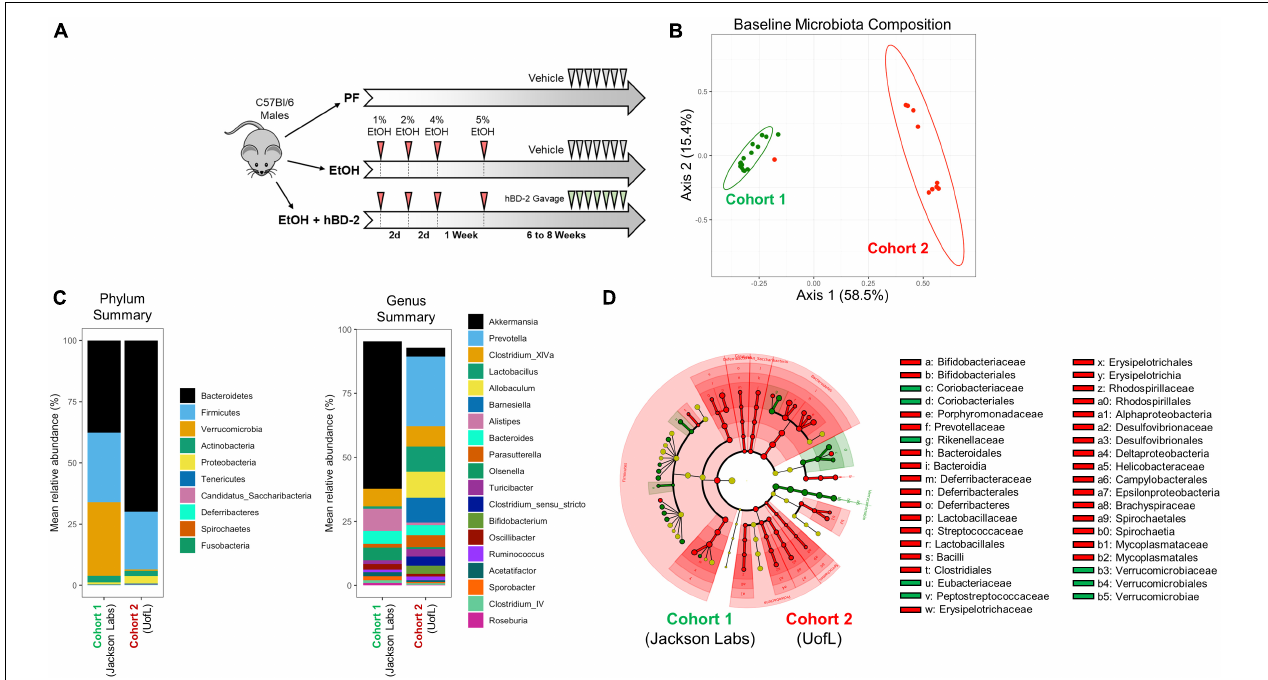
FIGURE 1 | Experimental design and gut microbiota differences between cohorts at baseline. (A) Schematic representation of study design. Two cohorts of male C57BL/6J mice were subjected to chronic EtOH feeding for 6–8 weeks in three experimental groups: pair-fed (PF), EtOH-fed + vehicle, EtOH-fed + hBD-2. hBD-2 was administered daily by oral gavage on the final 7 days of the EtOH feeding. (B) Principal coordinate analysis using Bray-Curtis distance from fecal 16S sequencing data showing independent microbiota between the two cohorts at baseline, before EtOH feeding began. Individual data points are shown as points with indicated cohort 50% confidence interval. PERMANOVA p = 0.001 between the cohorts. (C) Phylum- and genus-level summary of mean relative bacterial abundance between the cohorts at baseline. (D) LEfSe cladogram generated from fecal 16S sequencing data showing significant differences in taxonomical groups of bacteria at baseline associated with Cohort 1 (green) or Cohort 2 (red).